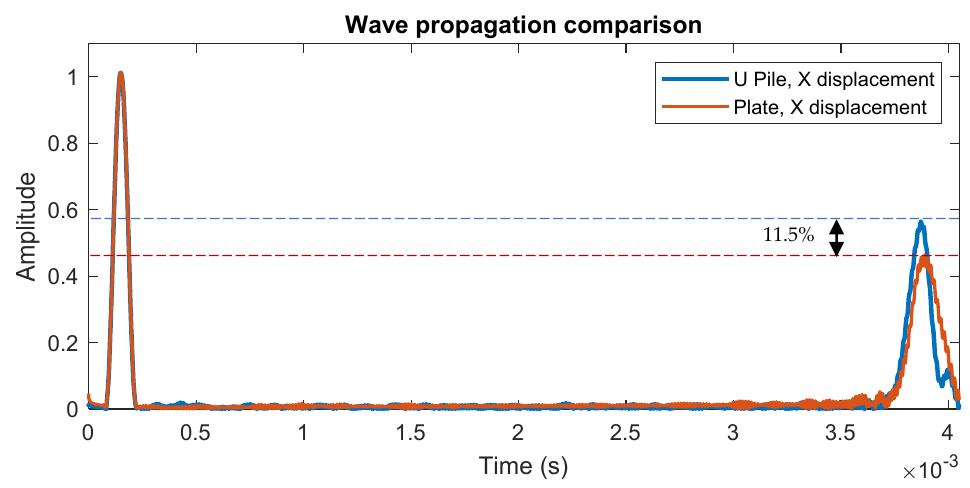
Figure 14. Wave propagation comparison between the plate and the web of the U-pile.